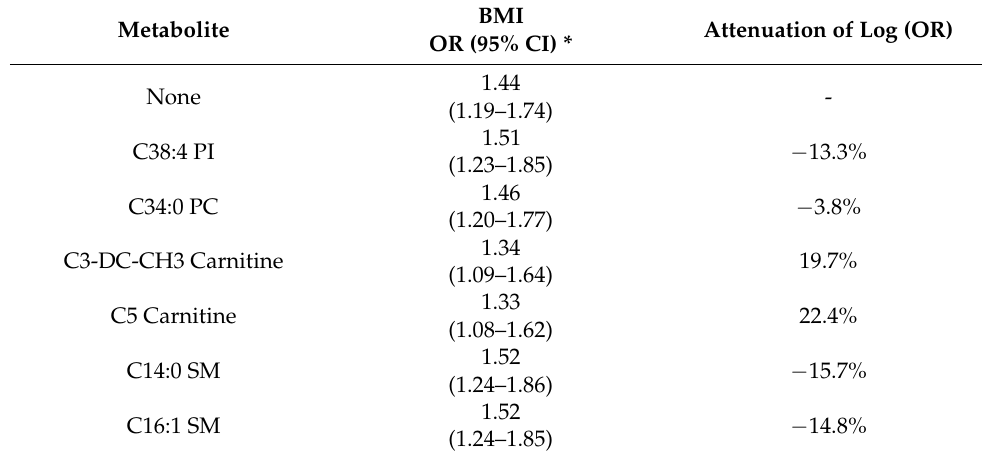
Table 4. Attenuation of the odds ratio for the BMI-renal cell carcinoma association with the addition (one at a time) of each of the six identified metabolites to the adjustment set.